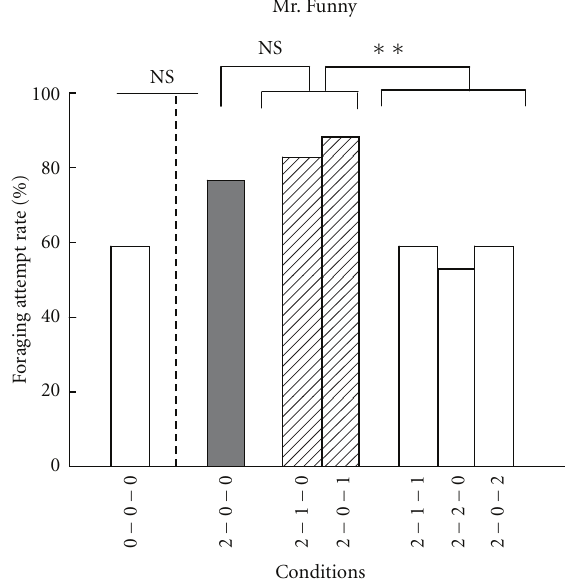
Figure 8: “Foraging attempt” rates for successive visibility. The “foraging attempt rates” were expressed as the percentage of “attempt made” trials over the total number of trials in each con- dition. The number of sessions completed was 16. ∗∗ : P < . 01. P values are two tailed.